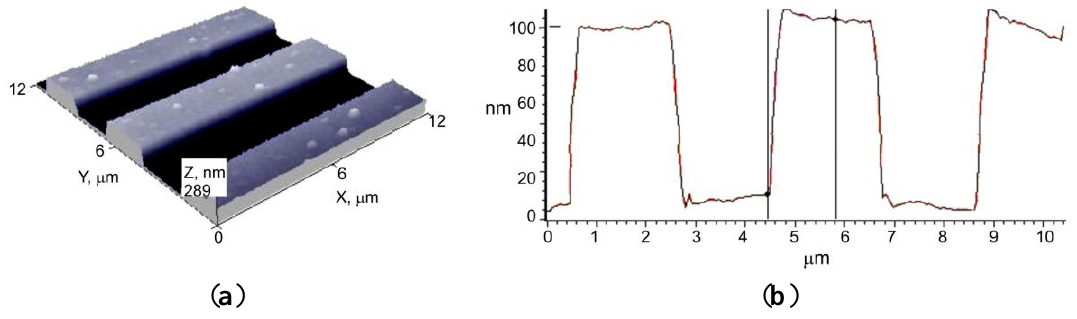
Figure 12. ( a ) 3D and ( b ) 2D view of the